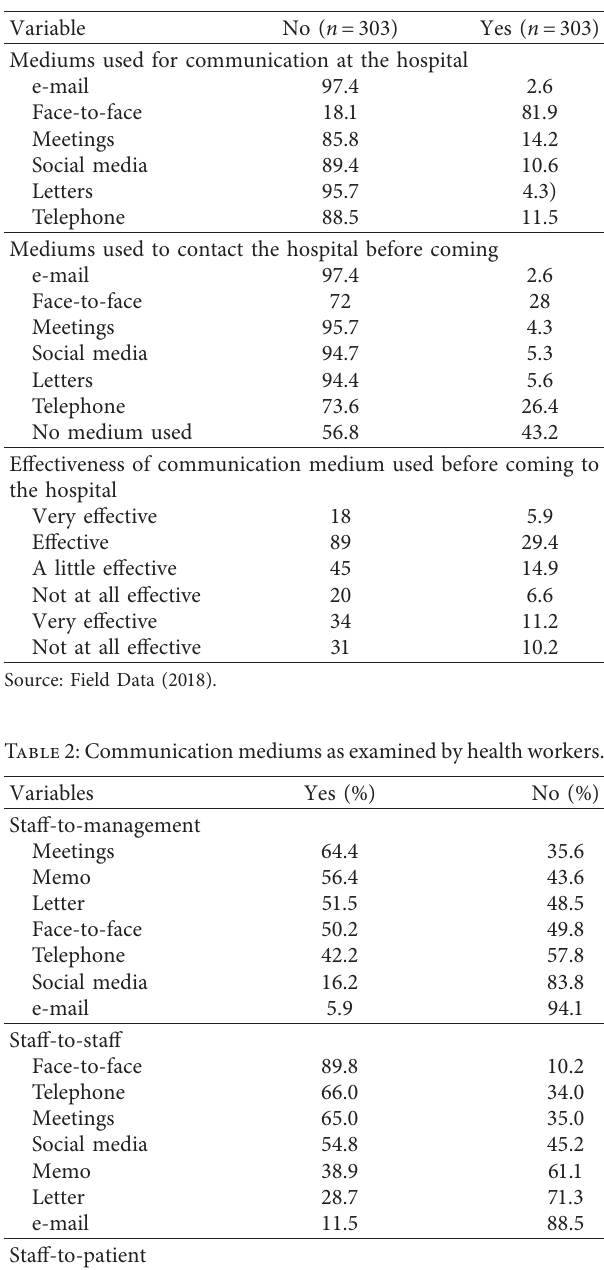
Table 1: Communication mediums as examined by